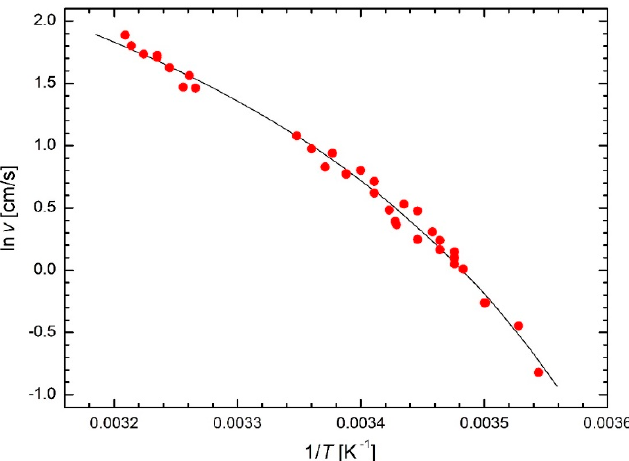
Figure 13. Modified Arrhenius plots for the speed of ant Liometopum apiculatum [31,32] based on Equation (23).